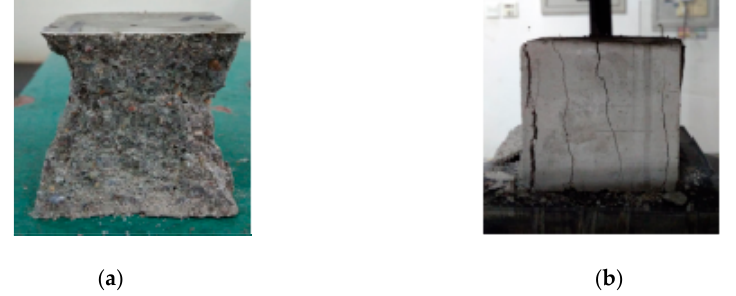
Figure 5. ( a ) The typical pyramid failure mode of a saturated specimen, ( b ) the columnar failure mode of a dry specimen.